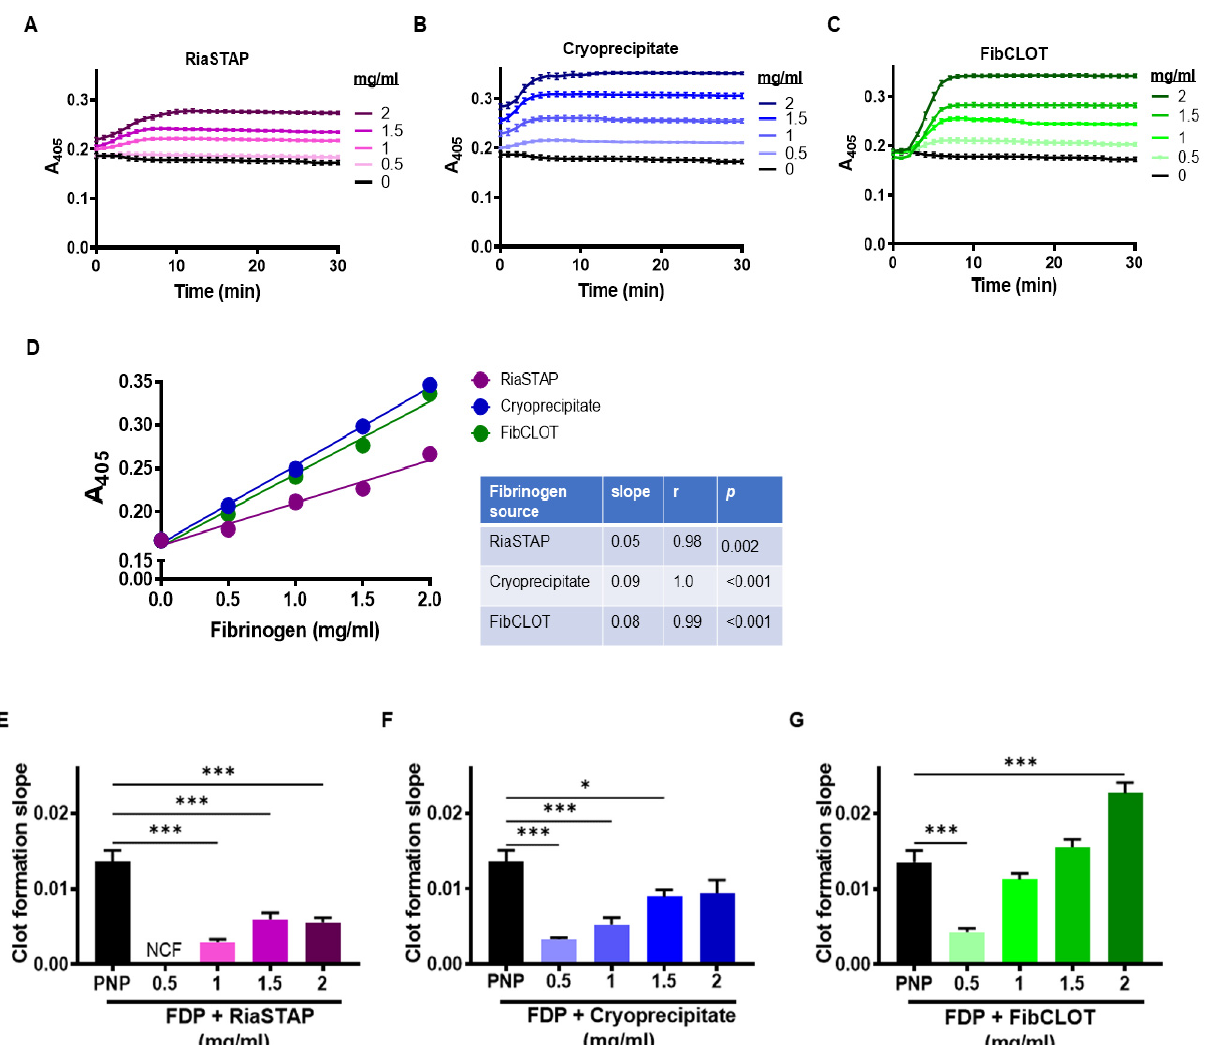
Figure 1. Supplementation of fibrinogen increases clot density. Clots contained 30% PNP or FDP, 16 µ M phospholipids, ± FibCLOT ® , RiaSTAP ® or cryoprecipitate at 0.5–2 mg/mL. Clotting was initiated with 0.1 U/mL thrombin and 10.6 mM CaCl2 and with a change in absorbance measured at 405 nm. ( A – C ) Absorbance curves. ( D ) Correlation of maximal absorbance with the concentration of fibrinogen. ( E – G ) Slope of clot formation, indicative of the rate of fibrin formation. Data shown are mean ± SEM, n = 4, * p < 0.05, and *** p < 0.001. The addition of FibCLOT ® , RiaSTAP ® or cryoprecipitate added at 1 mg/mL or higher significantly enhanced clot stability and generated 50% lysis times that were equivalent to or higher than that observed with PNP (Figure 2A–F). The strong concentration dependence was much more apparent with both cryoprecipitate and FibCLOT ® (Figure 2G), indicative of increased resistance against fibrinolysis